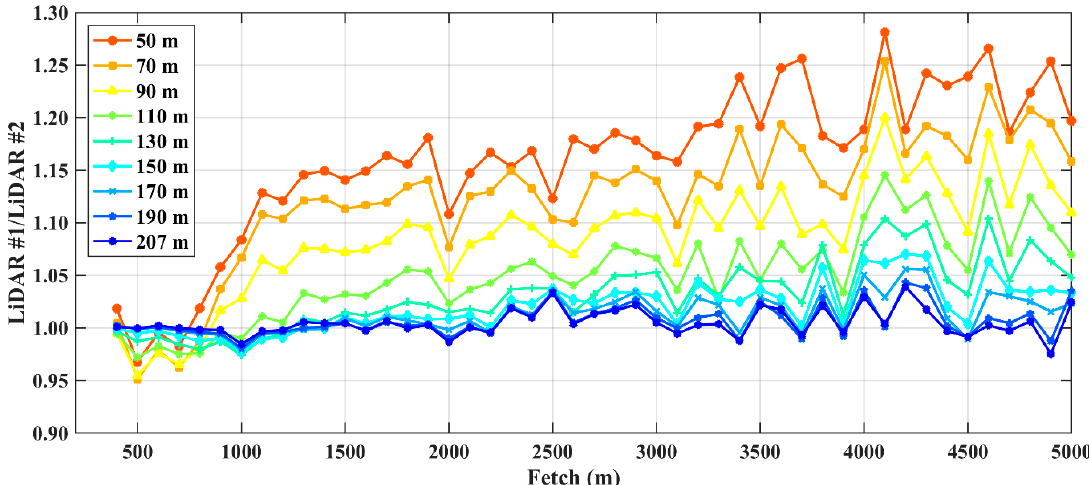
Figure 14. Bin-averaged wind speed ratio as a function of fetch length at heights of 50, 70, 90, 110, 130, 150, 170, 190, and 207 m ASL.